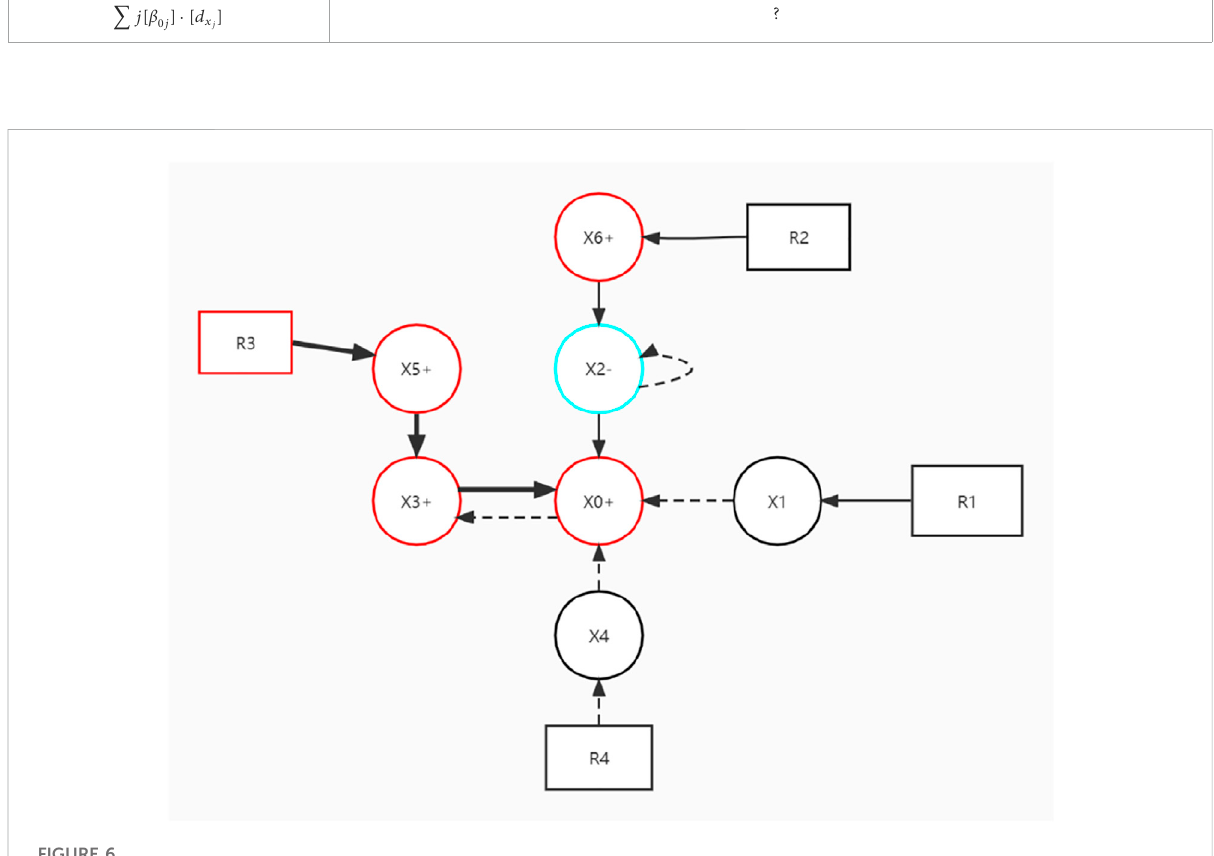
FIGURE 6 FR-SDG